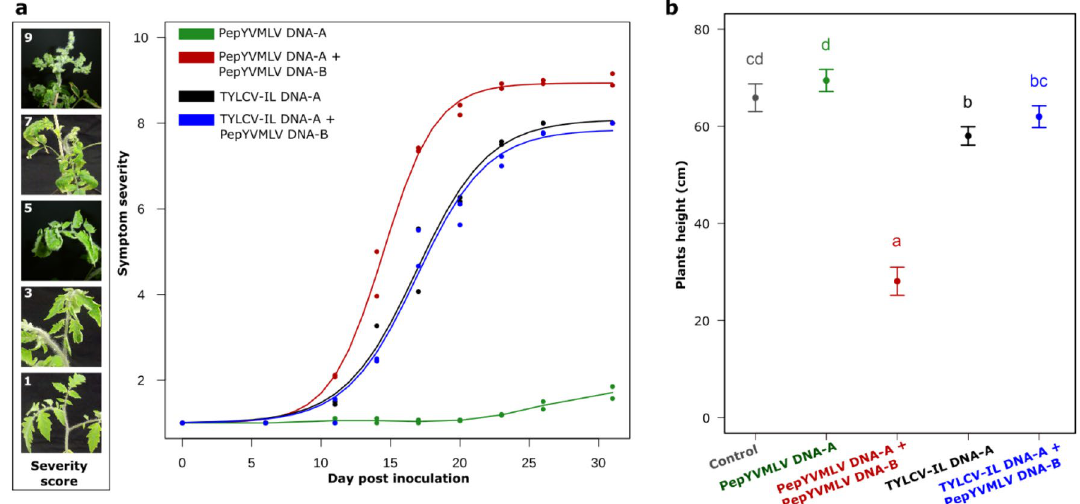
Figure 2. ( a ) Kinetics of estimated symptom severity of tomato (yellow) leaf curl disease following agroinoculation of tomato plants with PepYVMLV DNA-A and TYLCV-IL DNA-A in single (green and black lines) or mixed (red and blue lines) infection with DNA-B, respectively. Each point represents the average for one experiment (n = 30). The symptom severity scale (left scale bar) ranges from 1 (no symptoms) to 10 (plant death). ( b ) Mean height of tomato plants after agroinfection with PepYVMLV DNA-A or TYLCV-IL in single or mixed infection with DNA-B at 32 days post inoculation. For each dot, vertical bars represent 95% confidence intervals. Identical letters on top of the bars indicate groups with non-significant differences in height.